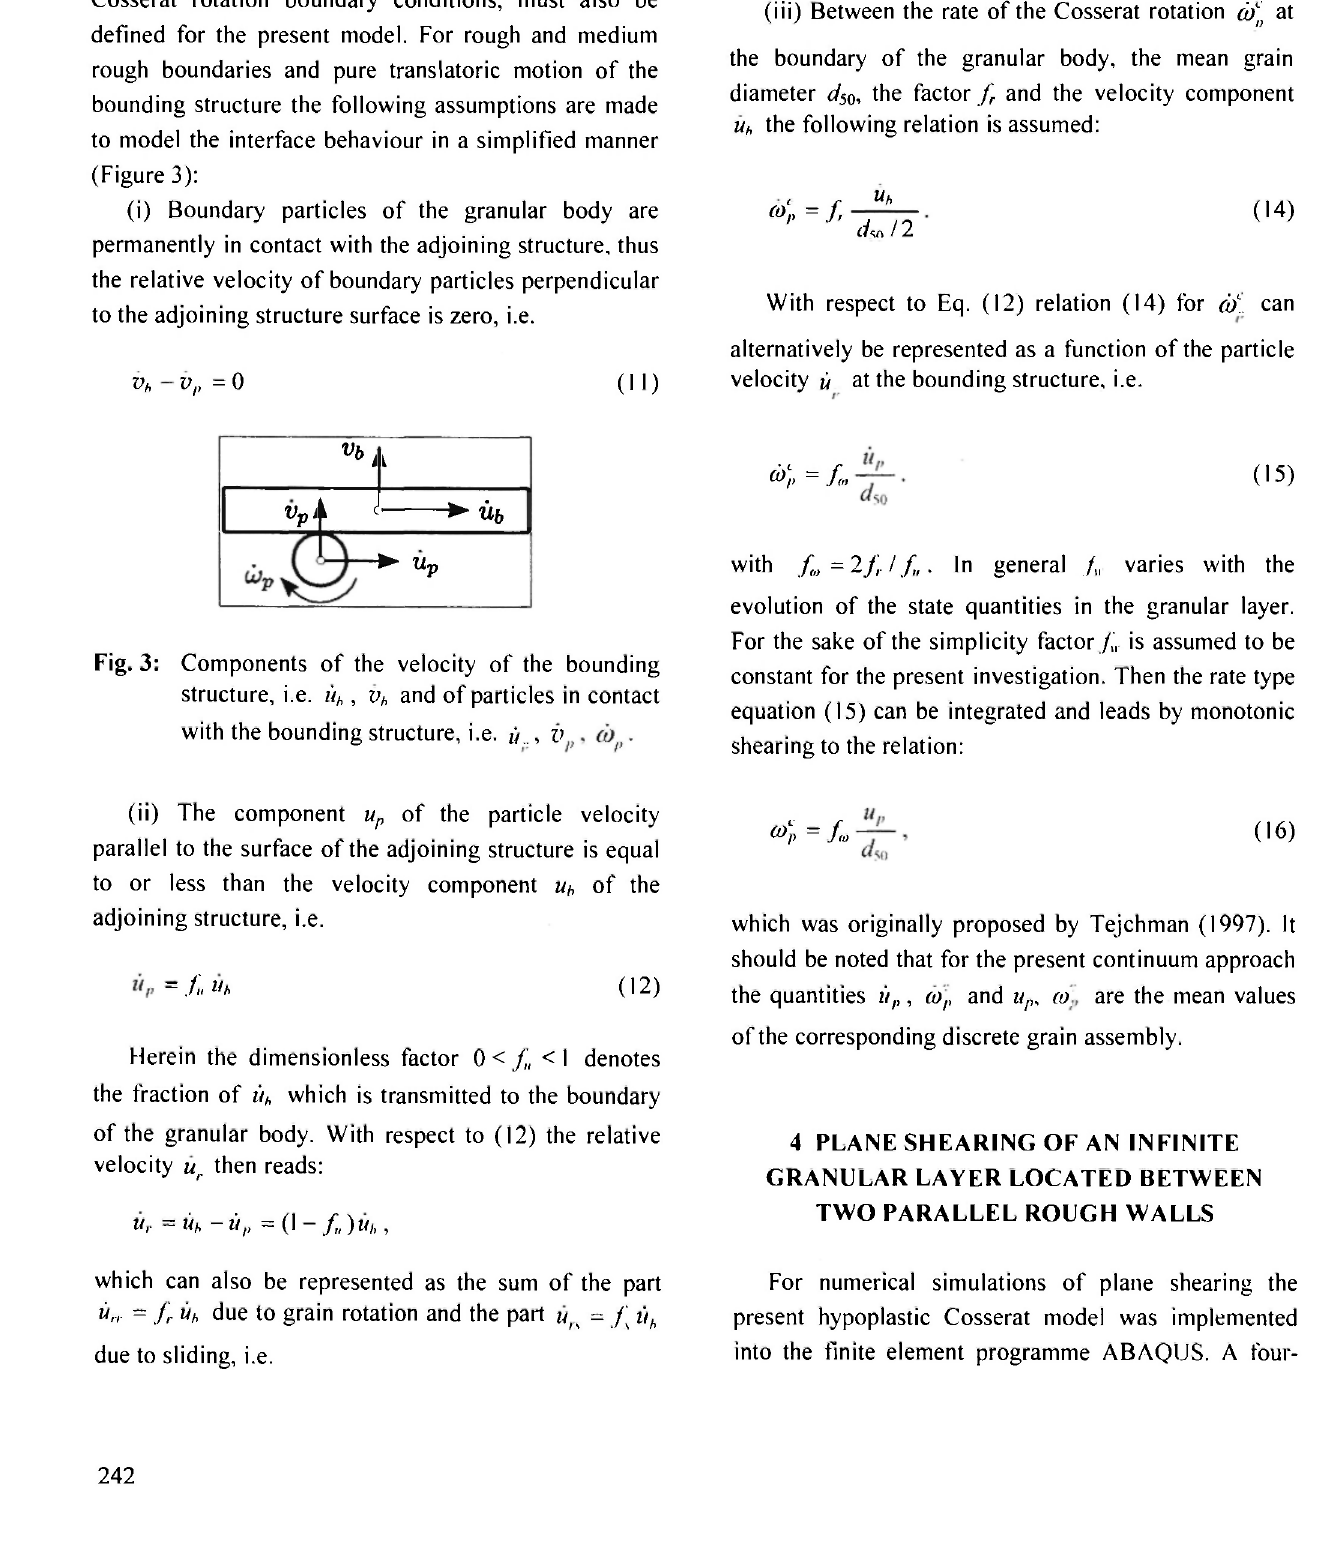
Fig. 3: Components of the velocity of the bounding structure, i.e. ü h , v h and of particles in contact with the bounding structure, i.e. ύ ,